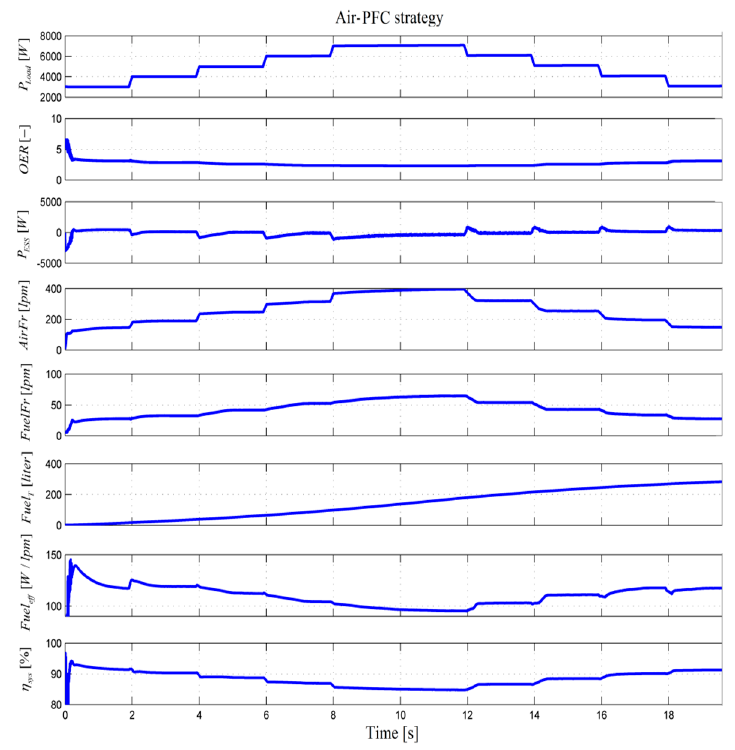
Figure 5. FC system behavior using air-PFC strategy [34].